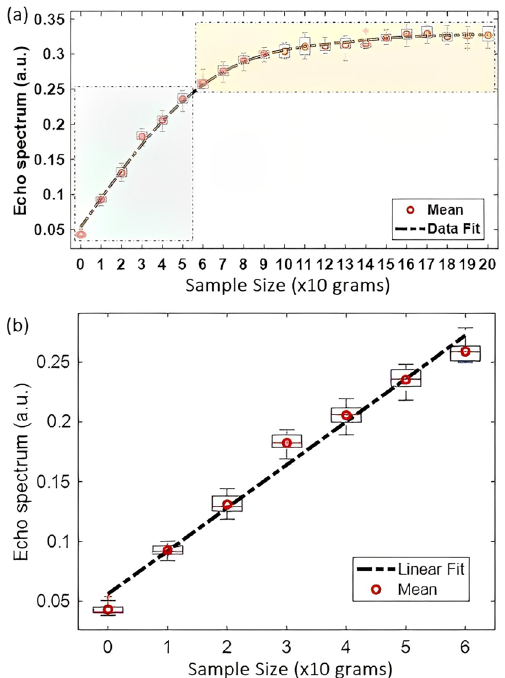
Figure 10. Analysis of planar coil sensitivity. ( a ) The initial amplitude, A , of NQR signals measured by the planar coil saturates with increasing sample thickness since the B 1 field generated by the planar coil does not uniformly excite all the 14 N nuclei. ( b ) The relationship between A and sample thickness is almost linear for thin samples (corresponding to the green region in ( a